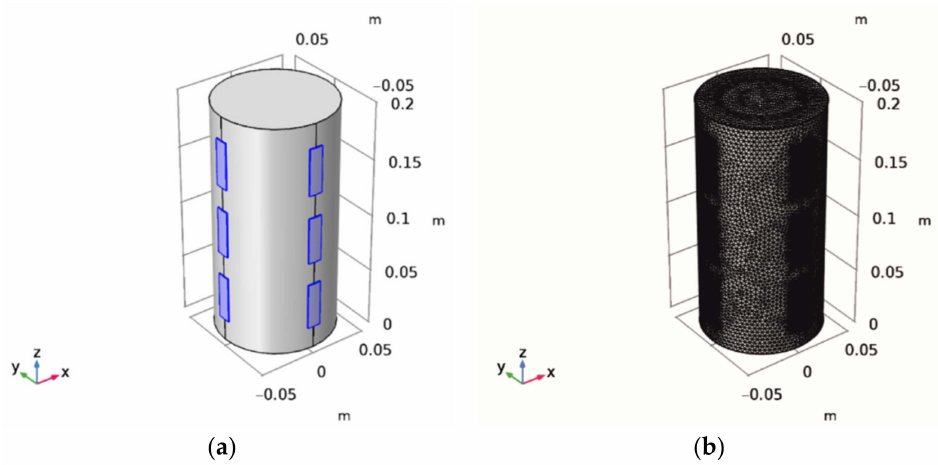
Figure 3. FEM model for cylindrical specimens consisting of a concrete cylinder (grey) and twelve electrodes (40 × 10 mm 2 ) at three height levels and with angular distances of 90 ◦ C (blue) ( a ) and grid model to simulate current flow with an extremely fine grid ( b